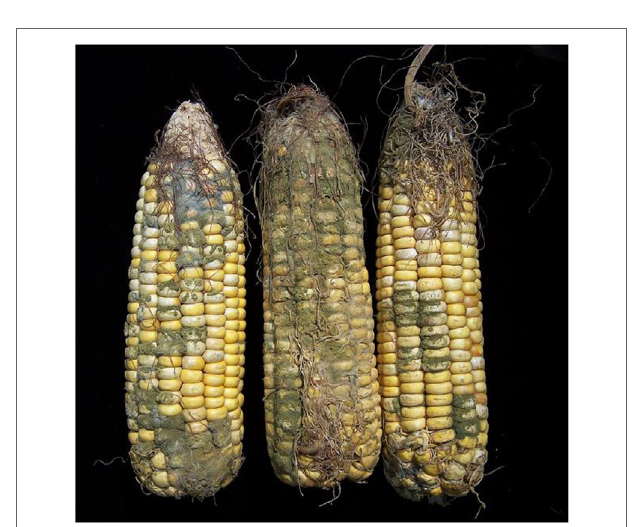
FiGURe 2 | Photograph of mycotoxin contaminated food: reproduced from Environmental Health Perspectives; September 2013, Volume 121, Issue 9, doi:10.1289/ehp.121-A270.